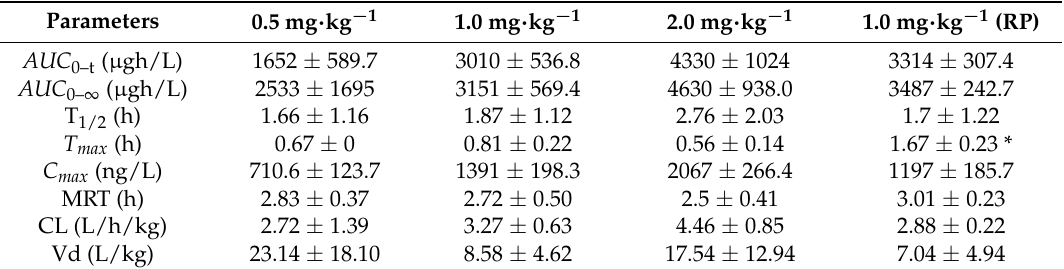
Figure 8. Plasma concentration–time curves for lansoprazole in test product and reference product groups at the dose of 1.0 mg · kg − 1 . Each point represents the mean ± S.D. ( n = 6). Table 6. Main plasma pharmacokinetic parameters of the three different doses of the lansoprazole test product and reference product, * p < 0.05 compared with T max (mean ± SD; n = 6).